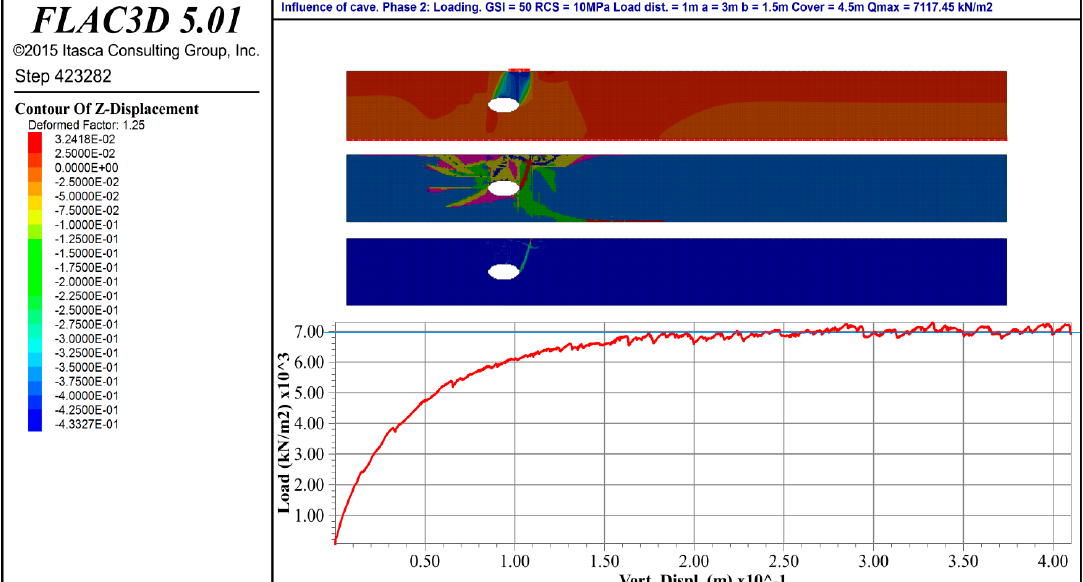
Figure 4. Case IEH-2. Eccentricity E/a = 2 ( mixed failure mechanism, by punching shear with inclined cut surfaces, plus classic plastic failure wedges). Each figure also represents the relation between the load applied (q i ) and the vertical displacement of the central point of the load surface, which allows the estimation of the value of the ultimate bearing capacity (q u ), as the load value of the horizontal asymptote of the diagram. Only the figures corresponding to the case IEH-2 are shown.